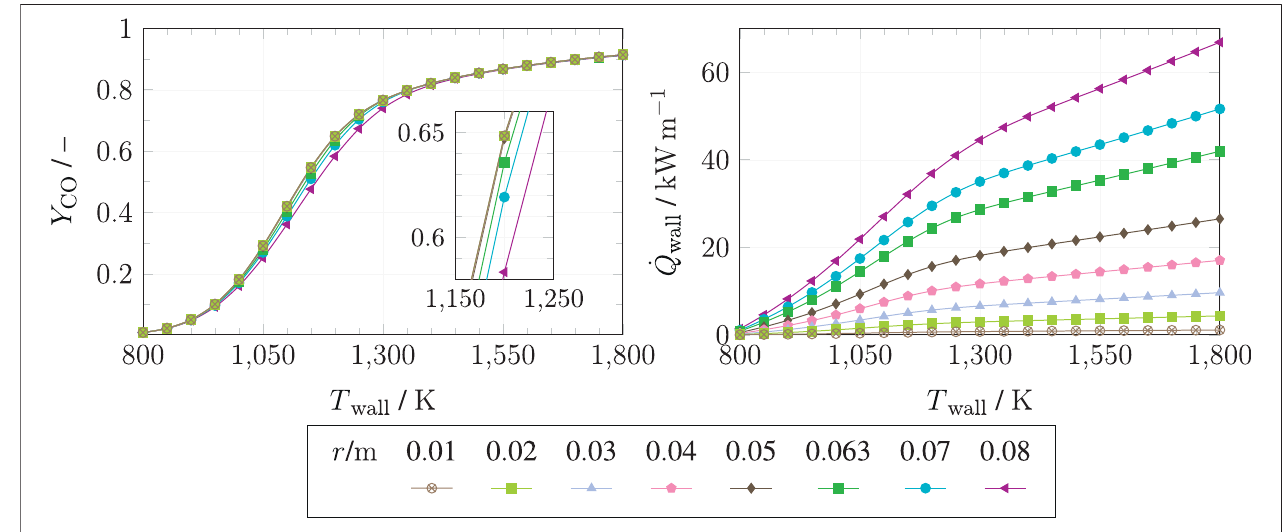
FIGURE5 | Yield ofCO, Y CO ofasingle reforming tube, and wall heat fl ux _ Q wall per meter oftube, asresult ofdifferentwalltemperatures T wall and inner tube radii r . The left graph contains a zoomed view of the curves at 1,200 K as overlayed subplot.